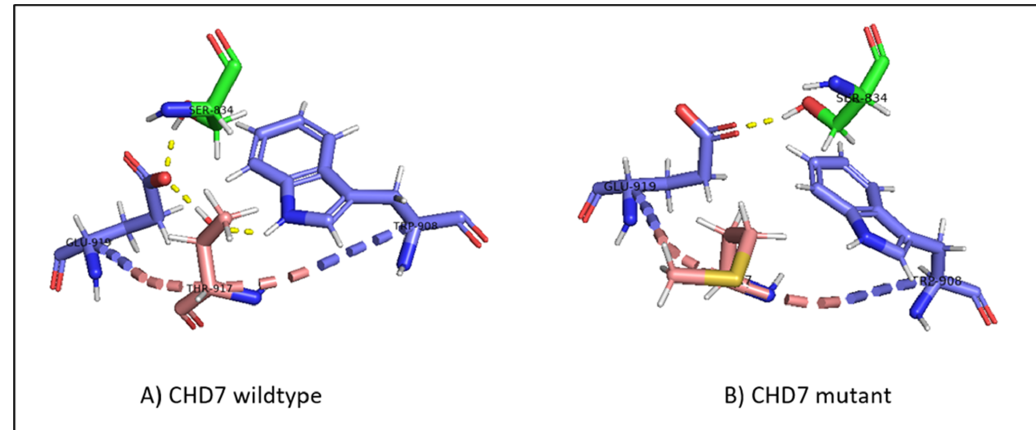
Figure 7. ( A ) The hydrogen bond network in wild-type CHD7, with T917 hydrogen bonding to E919 and W908, and E919 hydrogen bonding to S834. ( B ) The disruption of the hydrogen bond network in mutant CHD7. The introduction of the hydrophobic methionine causes the hydrogen bonds with E919 and W908 to be lost and M917 to flip away from the polar network. The mutation is highlighted in pink; the hydrogen bonds are highlighted in yellow dashed lines; residues belonging to the chromo 1 domain are highlighted in green. Although RMSF oscillates in both structures, the differences in fluctuations between the wild-type and mutant are very small. The peaks observed between regions 810 and 825, 850 and 880, 890 and 905, 950 and 980, and 1050 and 1080 correspond to loop regions and inter-domain linkers.